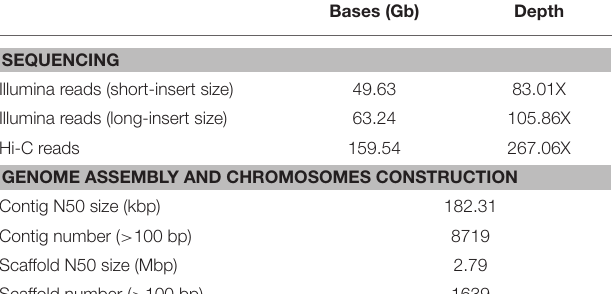
TABLE 1 | Summary of the L. maculatus genome assembly and annotation. Bases (Gb)